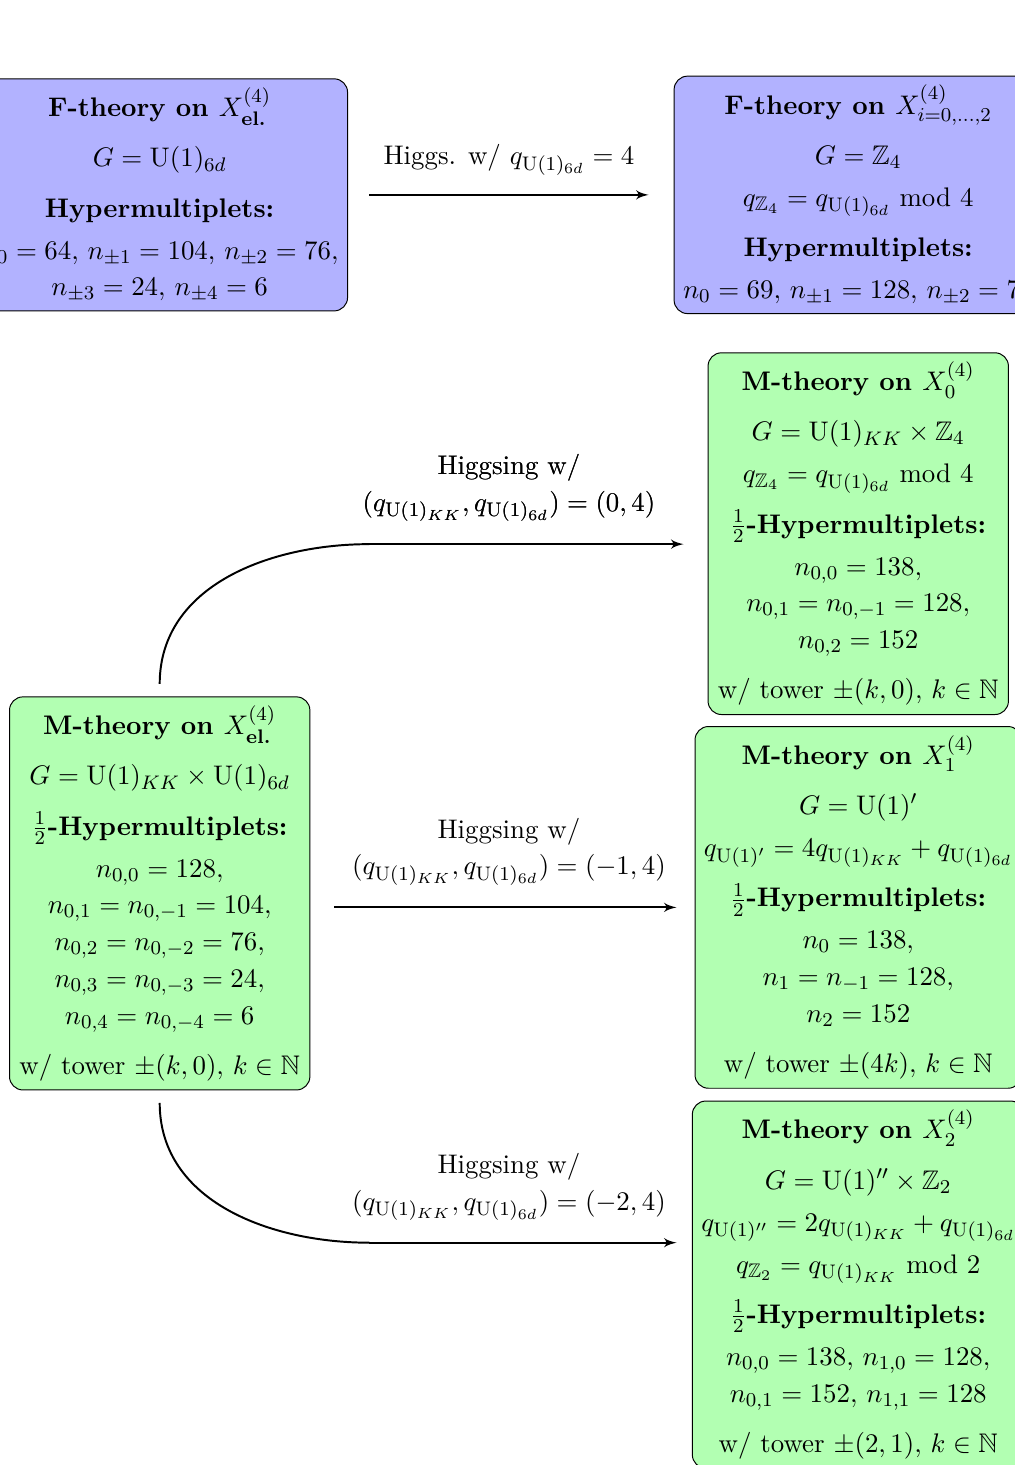
Figure 8 . The six- and five-dimensional gauge groups and matter spectra of F- and M-theory compactifications on X (4) and X (4) , as well as the relations via Higgs i =0 ,..., 2 el.